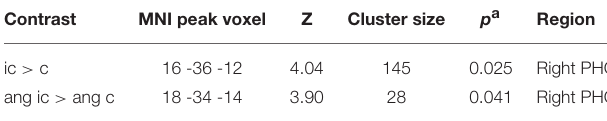
TABLE 2 | N100 source reconstruction results.